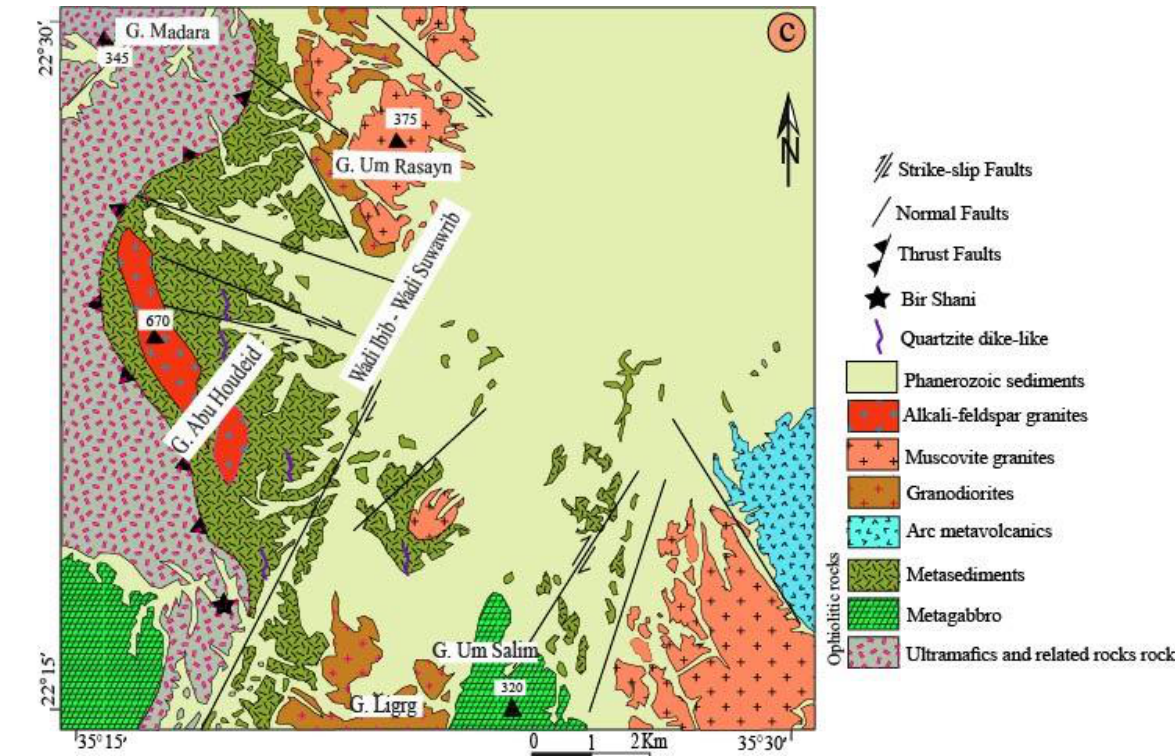
Figure 1. ( a ) Regional geological map of Egypt. ( b ) Distribution of Tonian ophiolite rocks [15]. In addition, location of the examined area, and ( c ) detailed geological map of Wadi Ibib (WI) – Wadi Suwawrib (WS) [19].